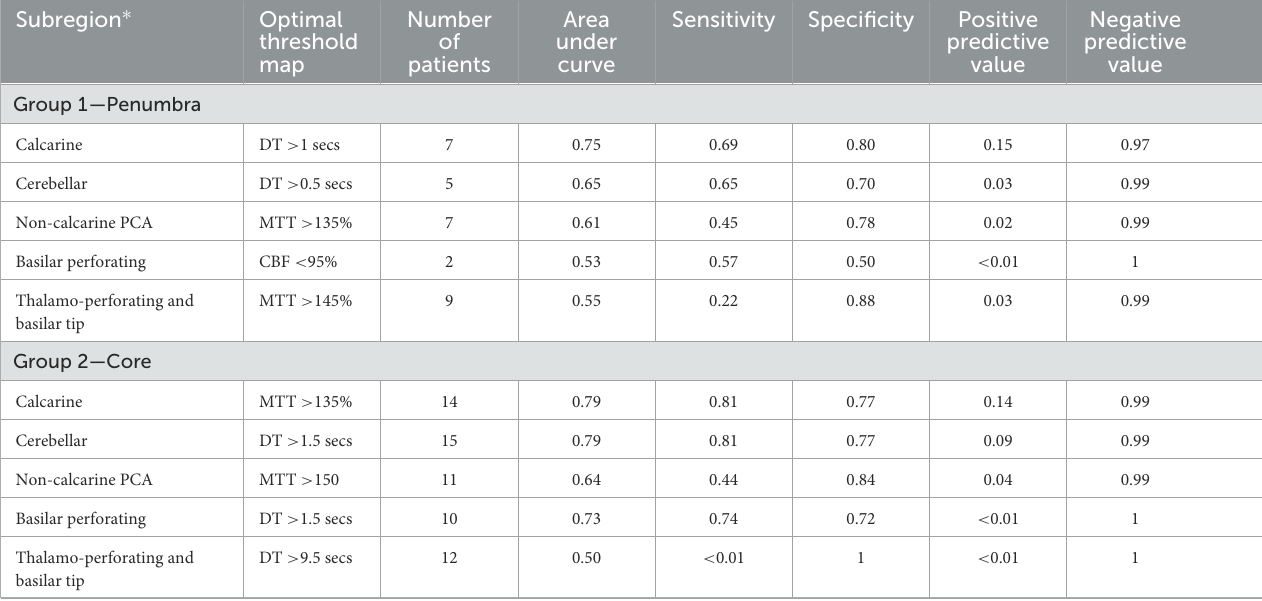
TABLE 3 Optimal perfusion thresholds to define penumbra and core according to voxel analysis by subregion. Subregion ∗ Optimal